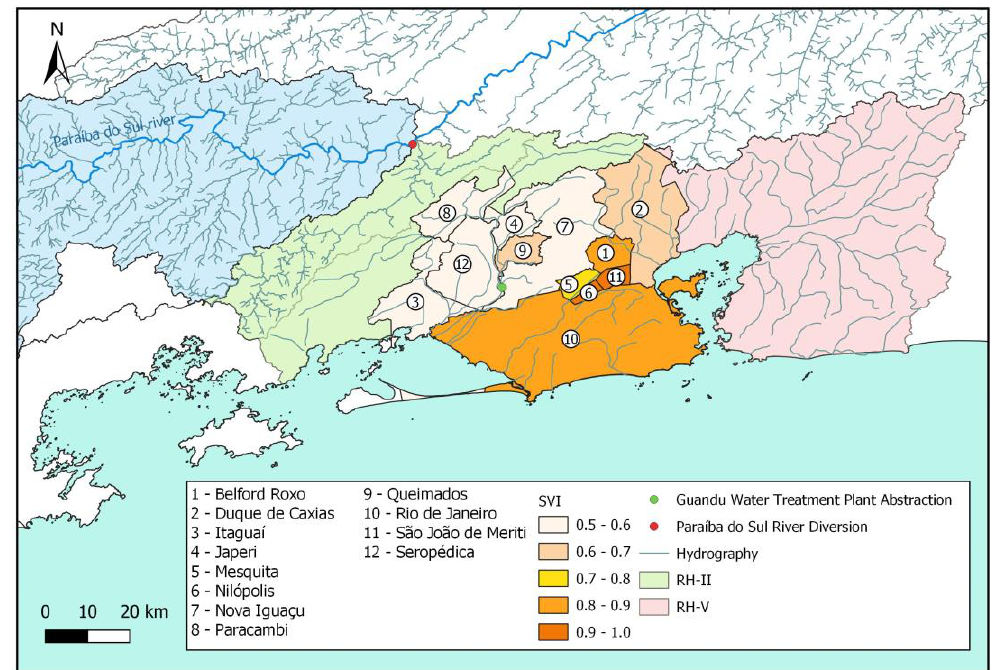
Figure 11. Social vulnerability indicator ( SVI ) application for each municipality supplied by the